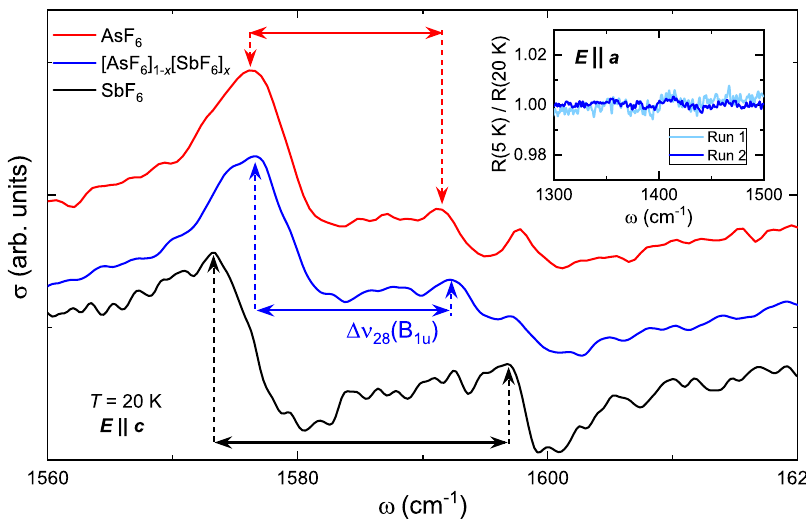
Figure 6. The ν 28 mode in (TMTTF) 2 [AsF 6 ] 1 − x [SbF 6 ] x with x = 0.3 is plotted at T = 20 K and compared to the parent compounds (TMTTF) 2 SbF 6 and (TMTTF) 2 AsF 6 [1,12]. The overall low- temperature spectrum is very similar for x = 0 and 0.3, with a smaller line splitting ∆ ν 28 than for x = 1. For better comparison of the peaks, the data were scaled and shifted by a vertical offset. Inset: Comparing the reflectivity for E (cid:107) a at 5 K and 20 K yields no enhancement of the ν 4 mode [1,36]; two distinct measurement runs of the same (TMTTF) 2 [AsF 6 ] 1 − x [SbF 6 ] x sample are shown. The absence of tetramerization indicates that the spin-Peierls phase is suppressed for a substitution x = 0.3, which is taken into account in Figure 1a.